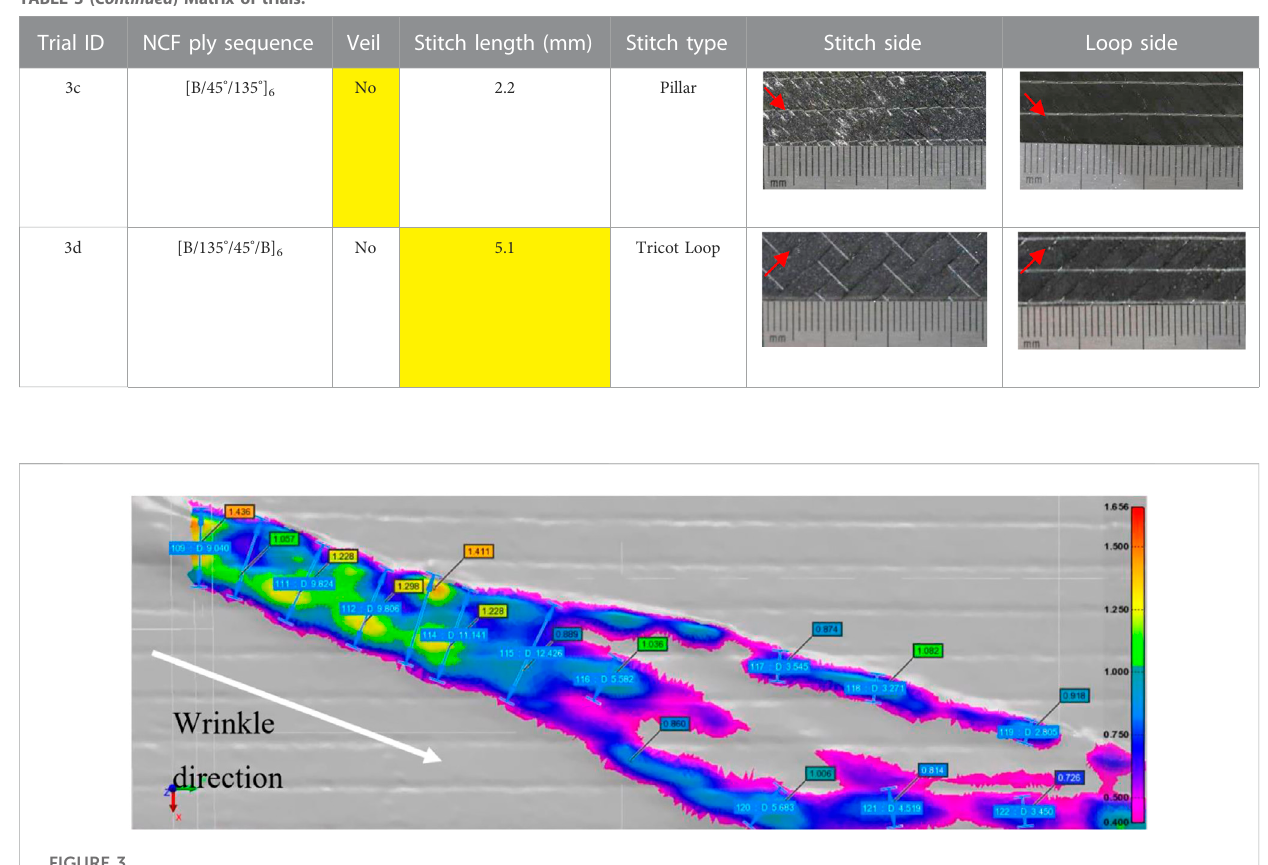
TABLE 3 ( Continued ) Matrix of